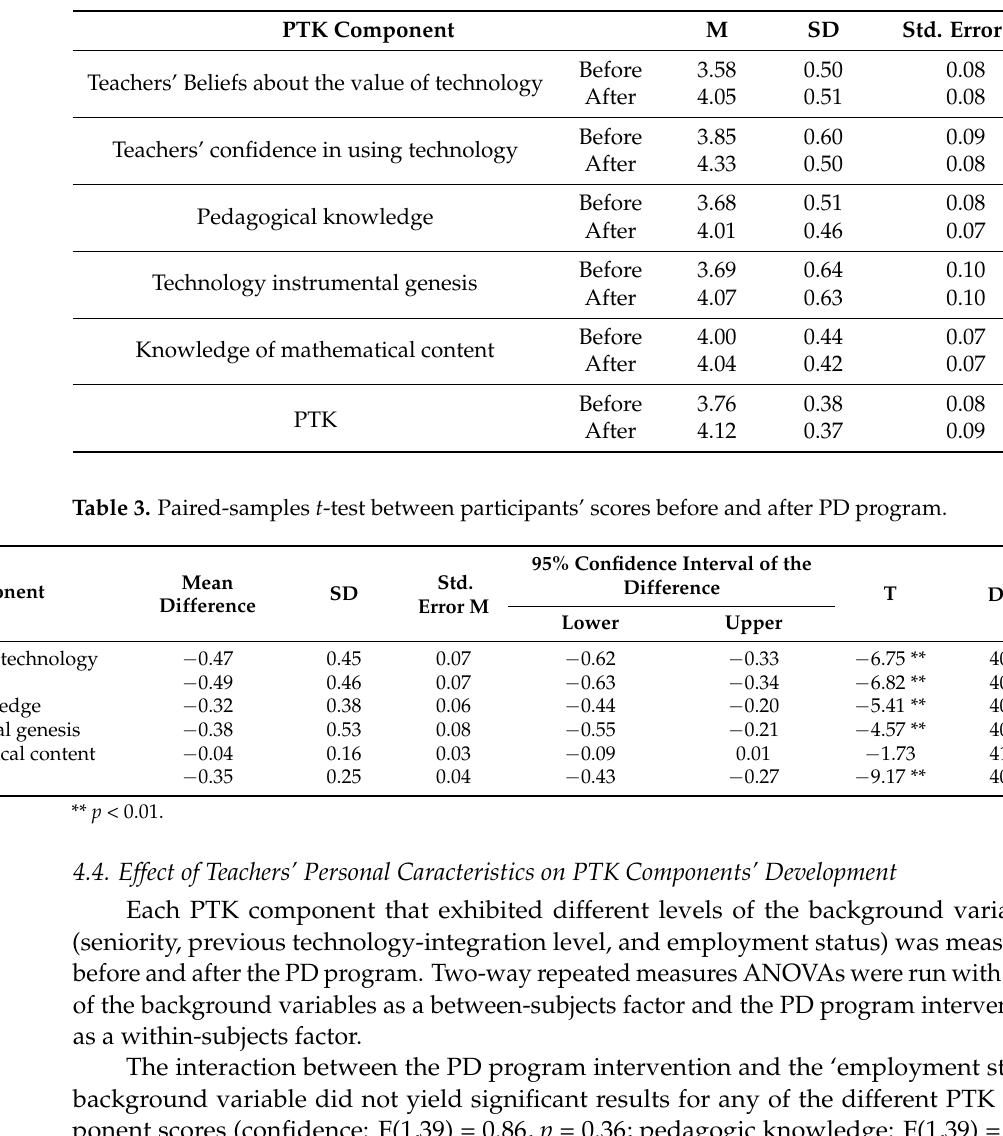
Table 2. Means, standard deviations, and standard error means for participating teachers’ knowledge components (N = 42).